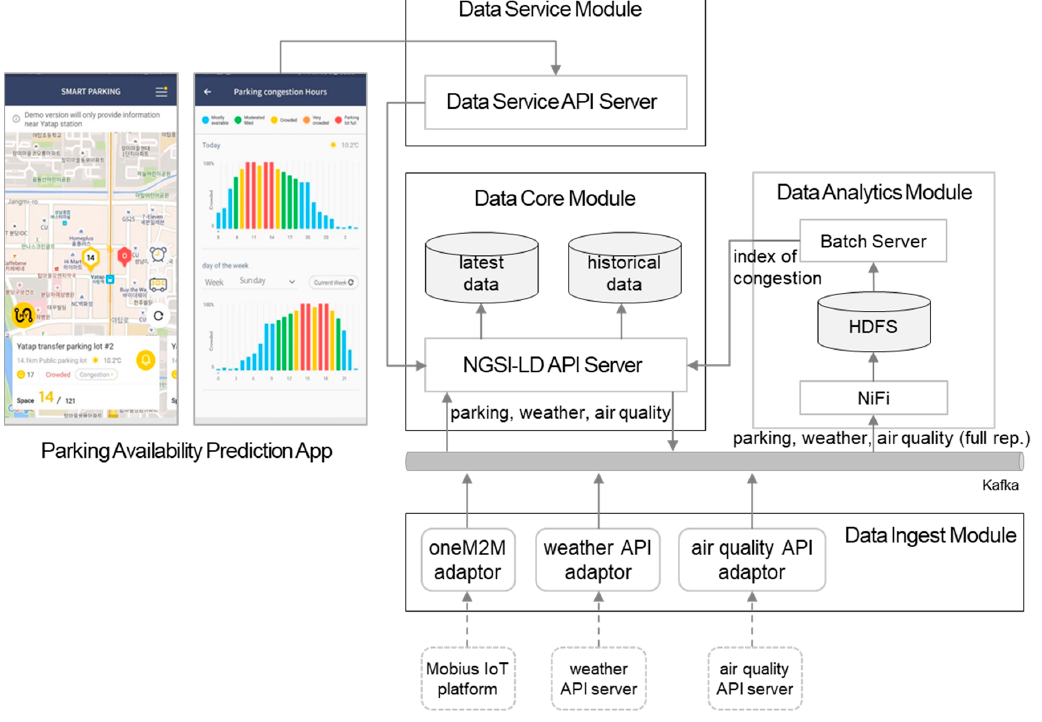
Figure 8. Parking availability prediction system.